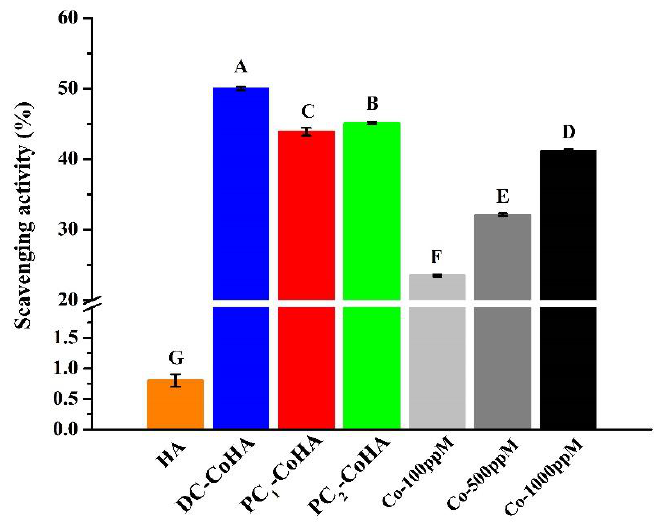
Figure 7. Free scavenging ratios of CoHA particles (p < 0.05).